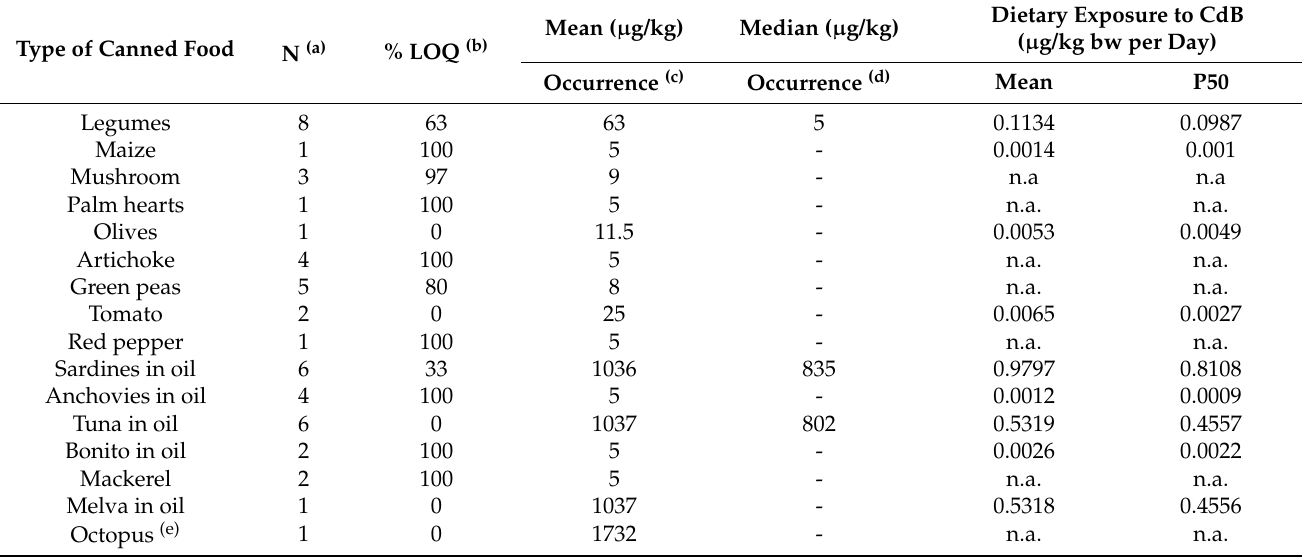
Table 3. Dietary exposure to CdB ( µ g/kg bw per